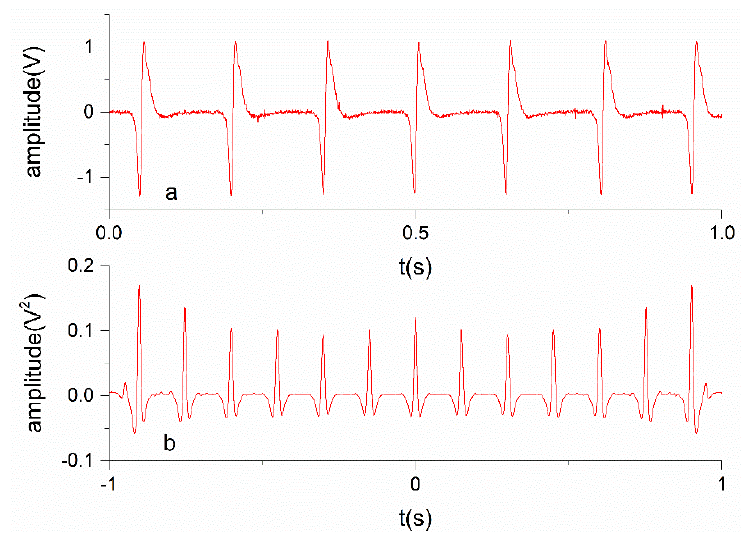
Figure 19. ( a ) Signal collected at the rotational speed of 400 rpm. ( b ) Auto-correlation of the signal.